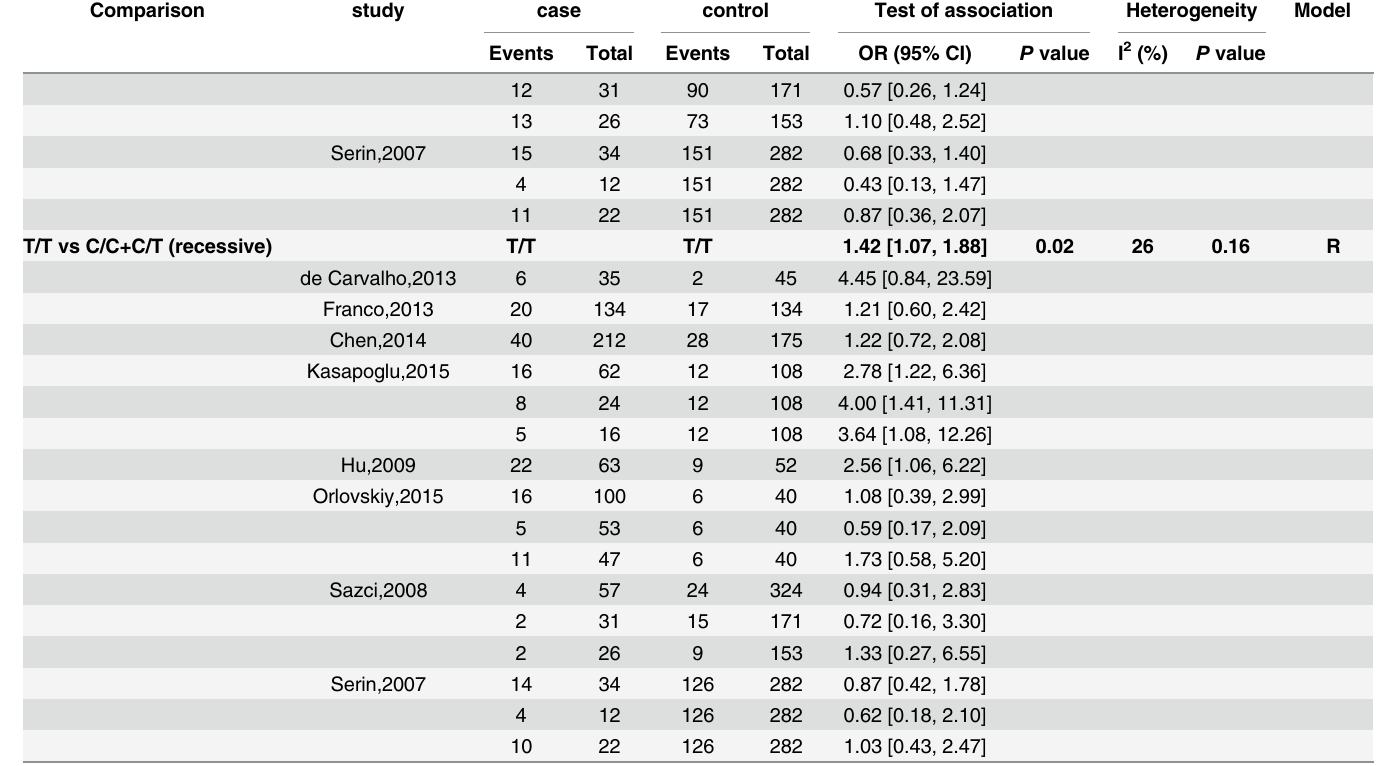
model (T/T vs C/C, OR = 1.49, 95% CI = 1.03~2.15, P = 0.04) and recessive model (T/T vs C/ C+C/T, OR = 1.42, 95% CI = 1.07~1.88, P = 0.02), but not the other genetics models (C/T vs C/ C, OR = 1.14, 95% CI = 0.93~1.39, P = 0.21; C/T+T/T vs C/C, OR = 1.18, 95% CI = 0.91~1.52, P = 0.21). In addition, the results of HWE test (Table 2) in control group of two studies [24, 25] indicated that the genotype distributions deviated from HWE ( Χ 2 = 5.605, P = 0.018; Χ 2 = 190.839, P < 0.05). The subgroup analyses under all genetic models were also performed based on ethnicity or HWE (Table 4) via Stata/SE 12.0 software. A significantly increased NAFLD risk was observed in Asian population (T vs C, OR = 1.58, 95% CI = 1.13~2.20, P = 0.007; T/T vs C/C, OR = 1.97, 95% CI = 1.15~3.37, P = 0.014; C/T vs C/C, OR = 1.72, 95% CI = 1.16~2.55, P = 0.007; C/T+T/T vs C/C, OR = 1.81, 95% CI = 1.26~2.59, P = 0.001) and HWE P > 0.05 sub- group (T vs C, OR = 1.31, 95% CI = 1.03~1.67, P = 0.030; T/T vs C/C, OR = 1.85, 95% CI = 1.15~2.97, P = 0.011; T/T vs C/C+C/T, OR = 1.72, 95% CI = 1.21~2.46, P = 0.003). In order to evaluate the influence of each study on the overall OR under all genetic models, the sensitivity meta-analyses, in which one study is omitted at a time, were also performed. As shown in Fig 3, the results indicated that the corresponding pooled OR value did not differ sig- nificantly from that of the overall meta-analysis. Furthermore, no significant publication bias was observed in all above genetic models via Begg ’ s funnel plot and Egger ’ s test (Data not shown), suggesting these results are reliable. These data indicated that the T/T genotype of MTHFR C677T polymorphism seems to be associated with genetic susceptibility to NAFLD, especially in Asian